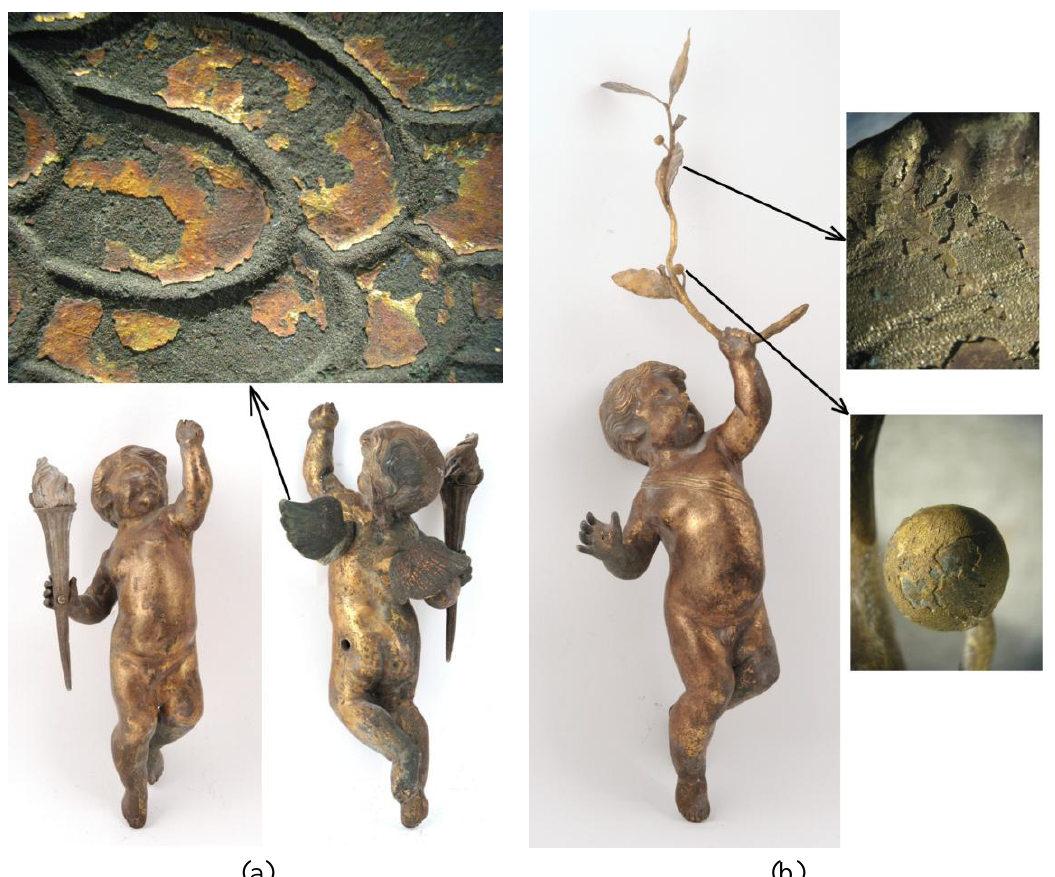
Figure 2. Pair of gilded bronze putti from the Wilanów Palace garden façade: (a) putto with torch, above—microscopic photograph of damage to the putto’s wing; (b) putto with laurel, left side—microscopic photographs of damage to the fruit and leaf.